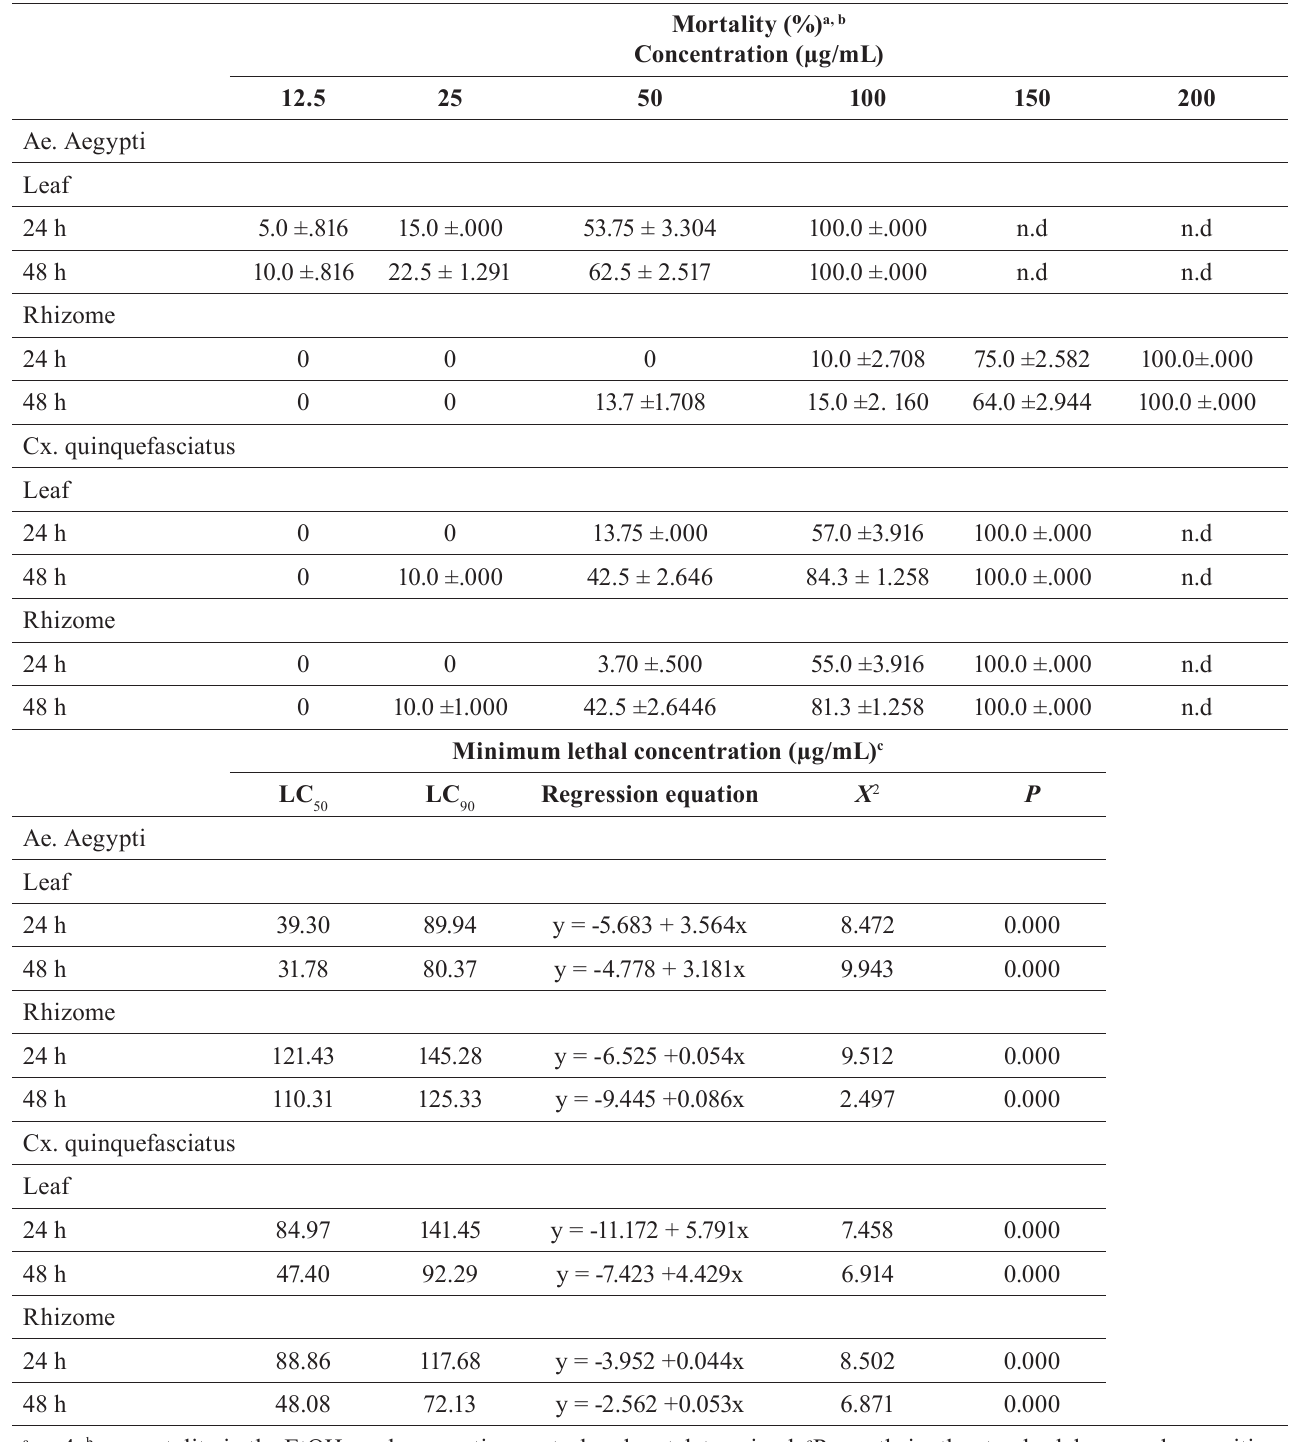
TABLE II - Mortality and larvicidal action of Z. castaneum